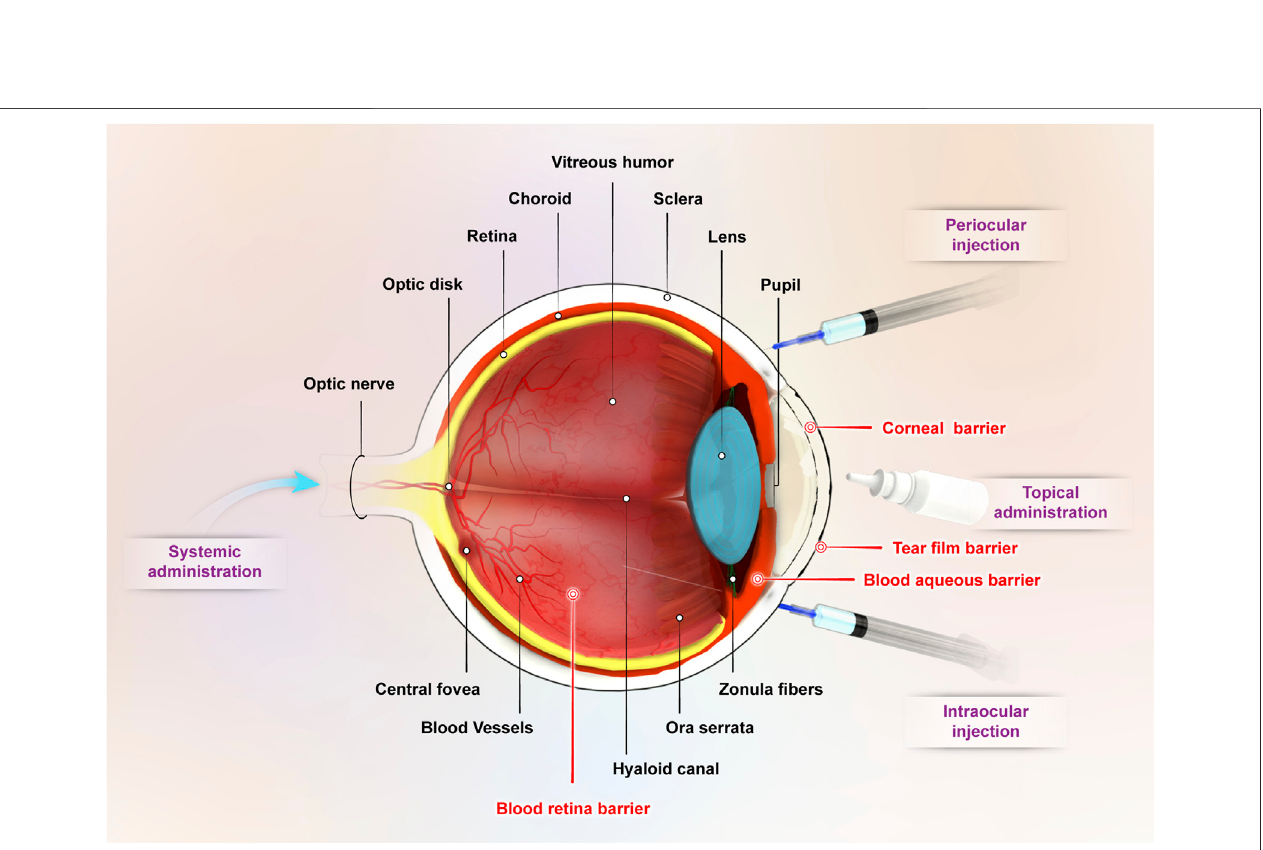
FIGURE 1 | Ocular structure and main routes of ocular drug administration.